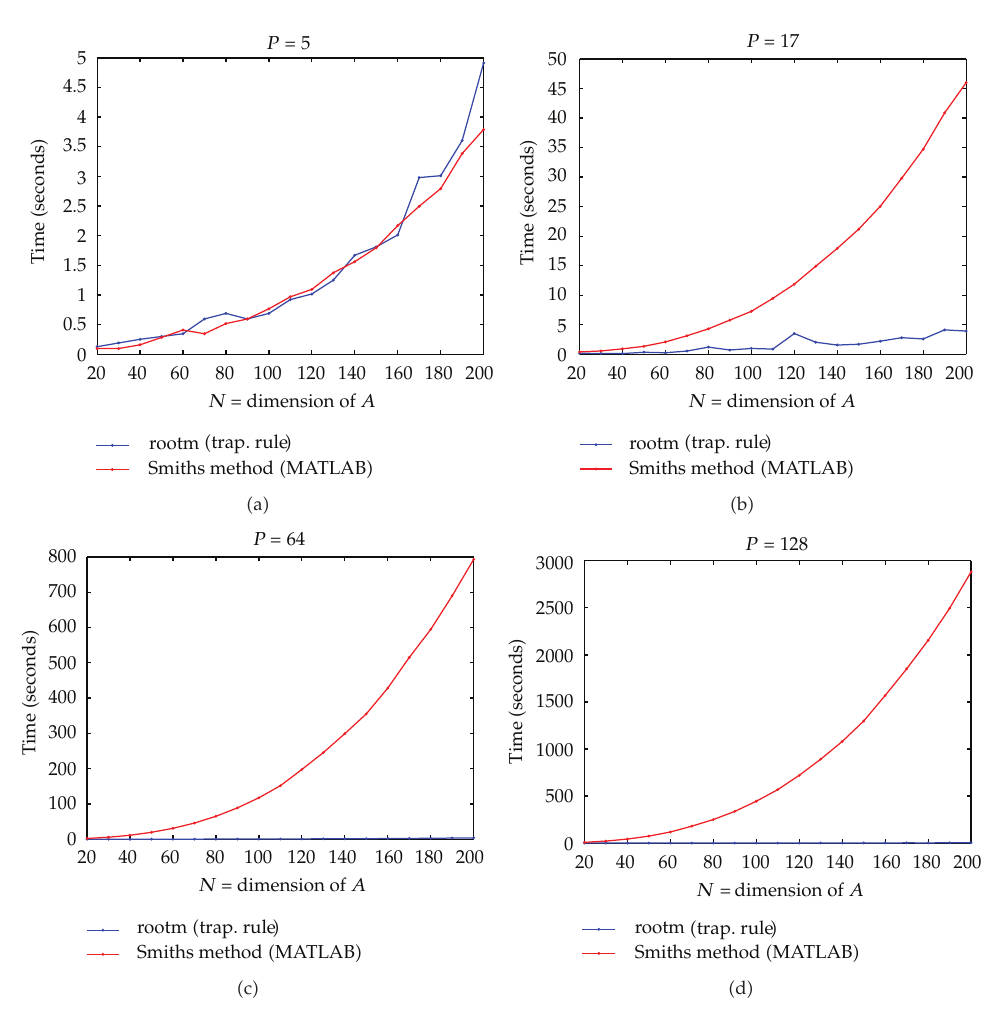
Figure 3: Time in seconds for computing A 1 /p for Random